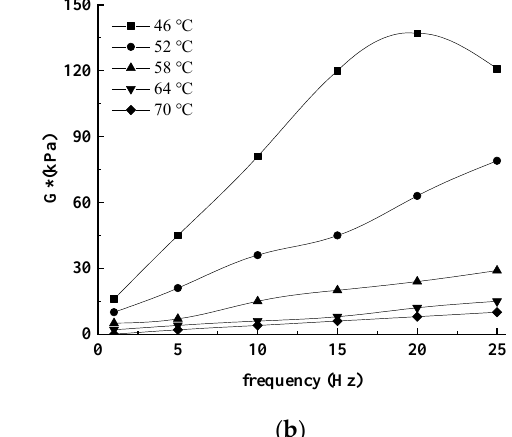
Figure 8. The variation curve of the complex moduli of different asphalts with frequencies: ( a ) rubber-powder-modified asphalt; ( b ) SBS-modified asphalt.